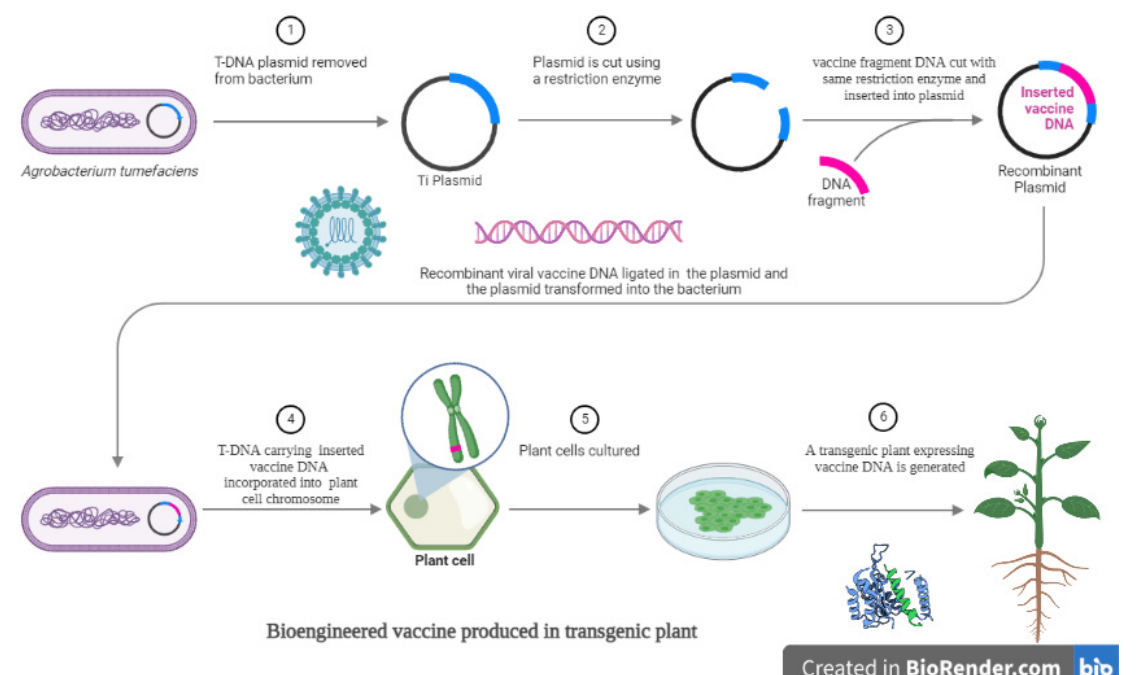
Figure 1. Bioengineered vaccine expressed and produced in transgenic plant.